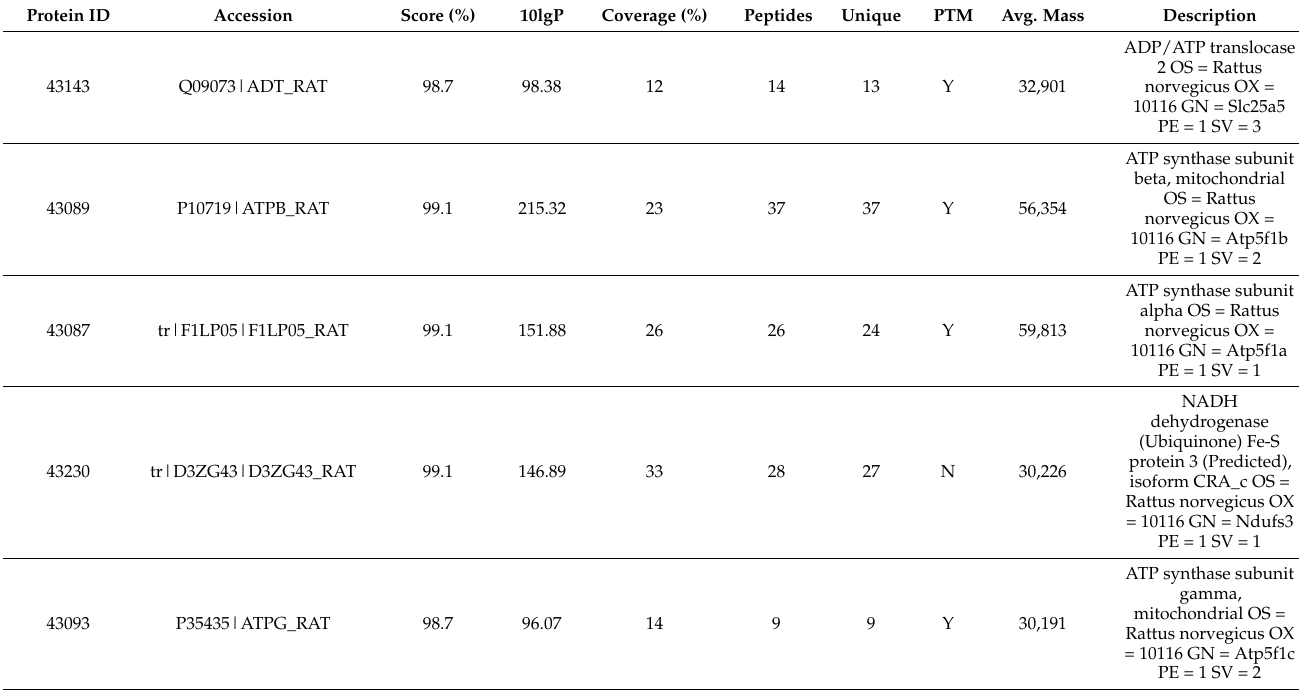
Table 2. The analysis results indicating protein candidates in the mitochondrial